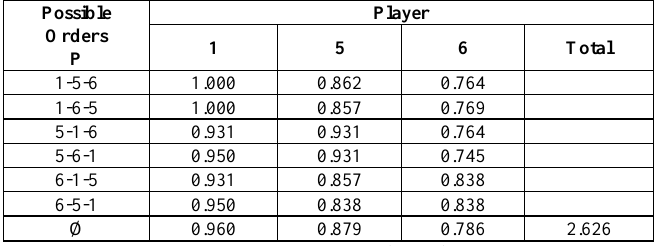
Table 7: Shapely value of 12-brood game, good